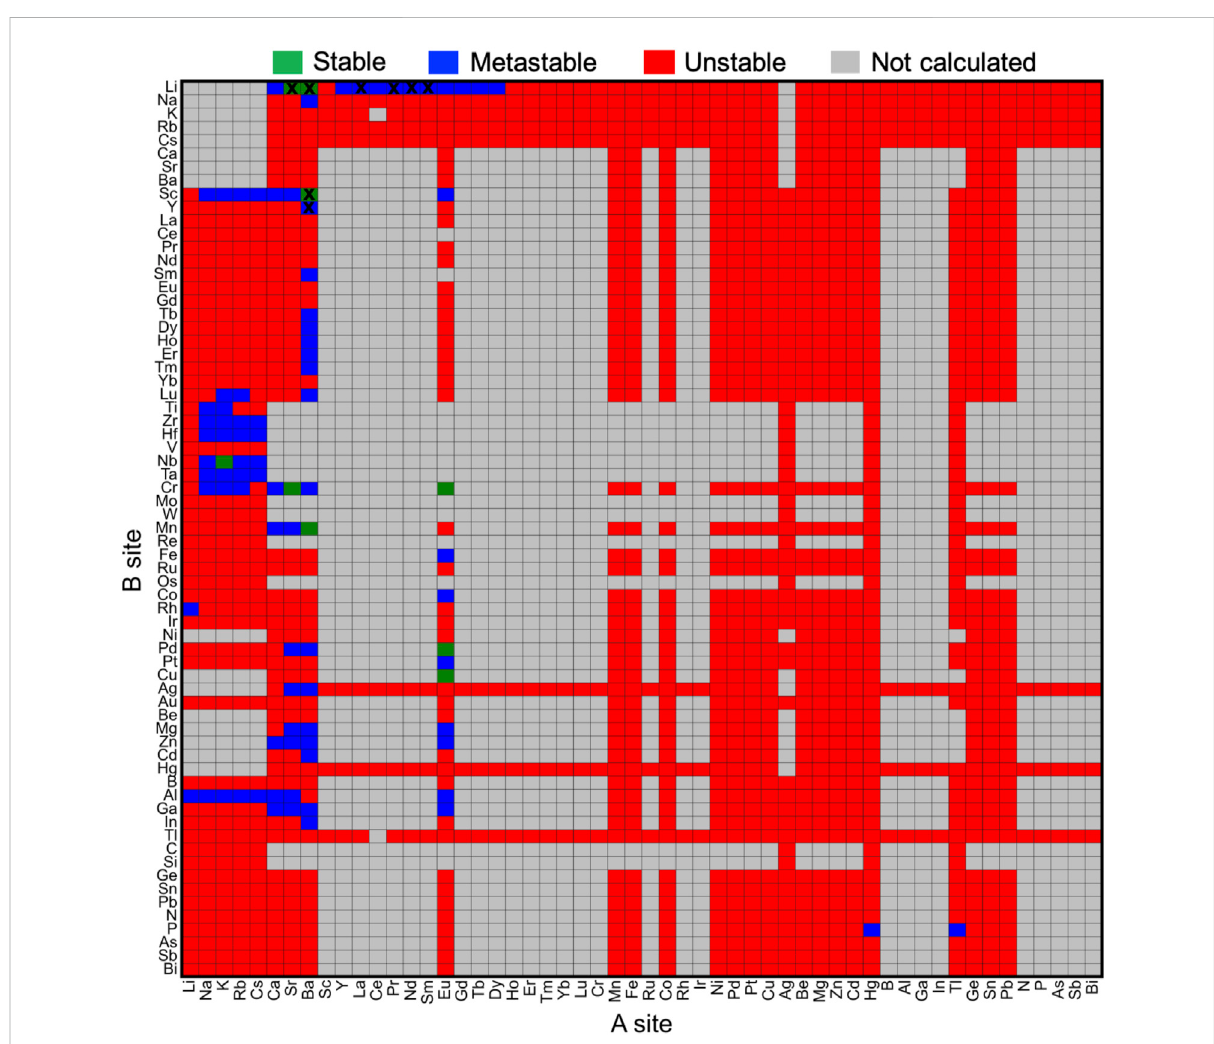
FIGURE 3 Stability map of the A 2 BH 1+ x O 3- x ( x = 0, 1, 2) oxyhydrides with elements occupying A and B sites, respectively. Stable ( Δ E hull = 0 meV/atom) and metastable (0 < Δ E hull ≤ 100 meV/atom) oxyhydrides are shown in green and blue, respectively, while unstable oxyhydrides with Δ E hull larger than 100 meV/atom are plotted in red. Compounds in gray are not calculated mostly due to the lack of charge-balanced compositions. The blocks marked by black crosses indicate synthesized compounds in experiments. Elements are ordered by the Mendeleev